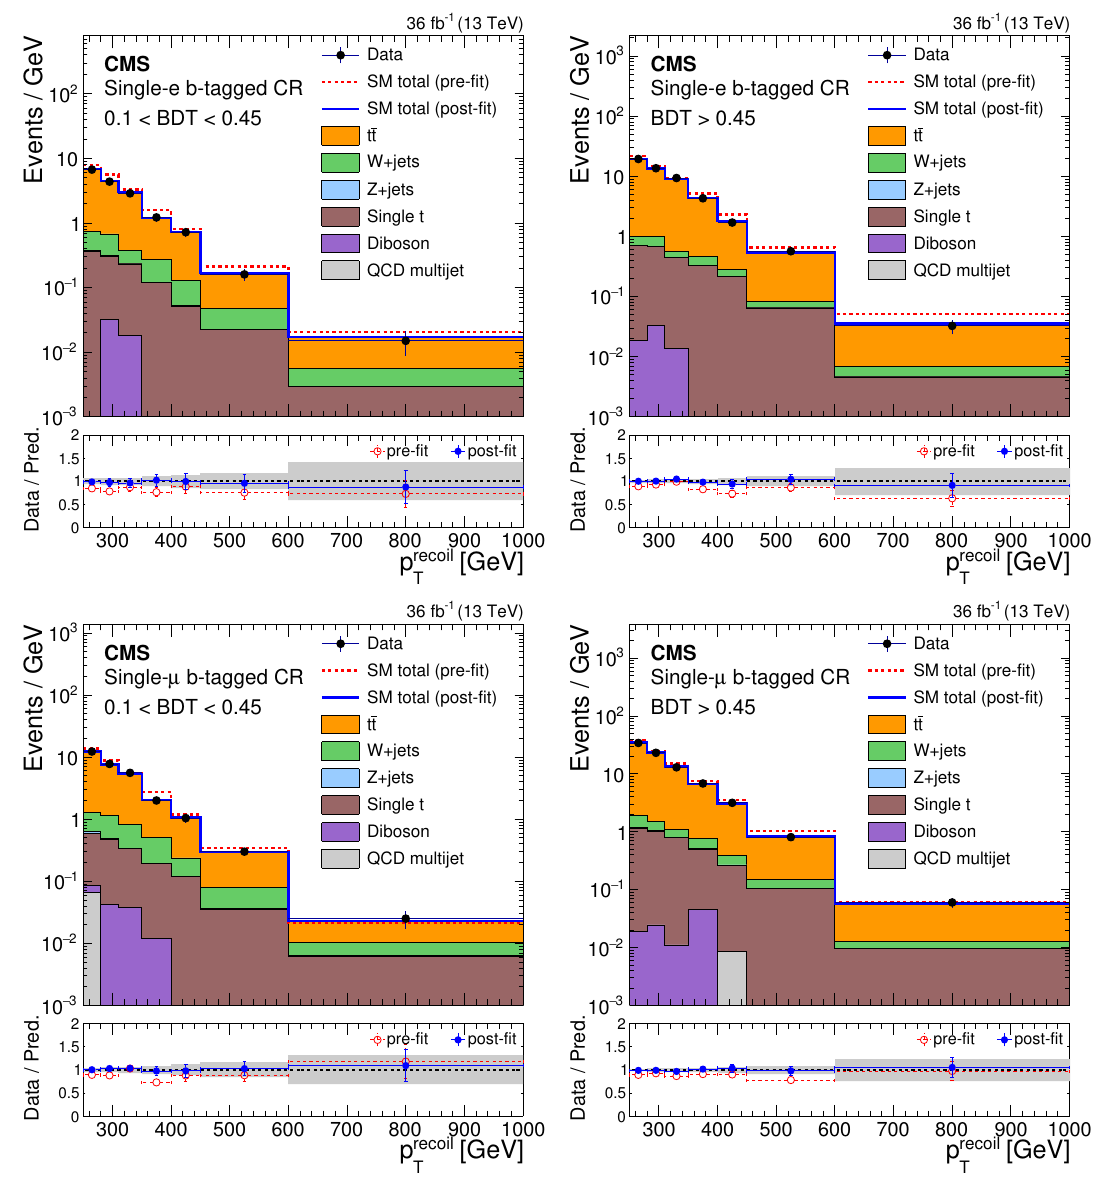
Figure 7 . Comparison between data and SM predictions in the b-tagged single lepton control regions before and after performing the simultaneous (cid:12)t to the di(cid:11)erent control regions and signal region. Each bin shows the event yields divided by the width of the bin. The upper row of (cid:12)gures corresponds to the single electron b-tagged control region, and lower row to the single muon b- tagged control region. The left (right) column of (cid:12)gures corresponds to the loose (tight) category of the control regions. The blue solid line represents the sum of the SM contributions normalized to their (cid:12)tted yields. The red dashed line represents the sum of the SM contributions normalized to the prediction. The stacked histograms show the individual (cid:12)tted SM contributions. The lower panel of each (cid:12)gure shows the ratio of data to (cid:12)tted prediction. The gray band on the ratio indicates the one standard deviation uncertainty on the prediction after propagating all the systematic uncertainties and their correlations in the